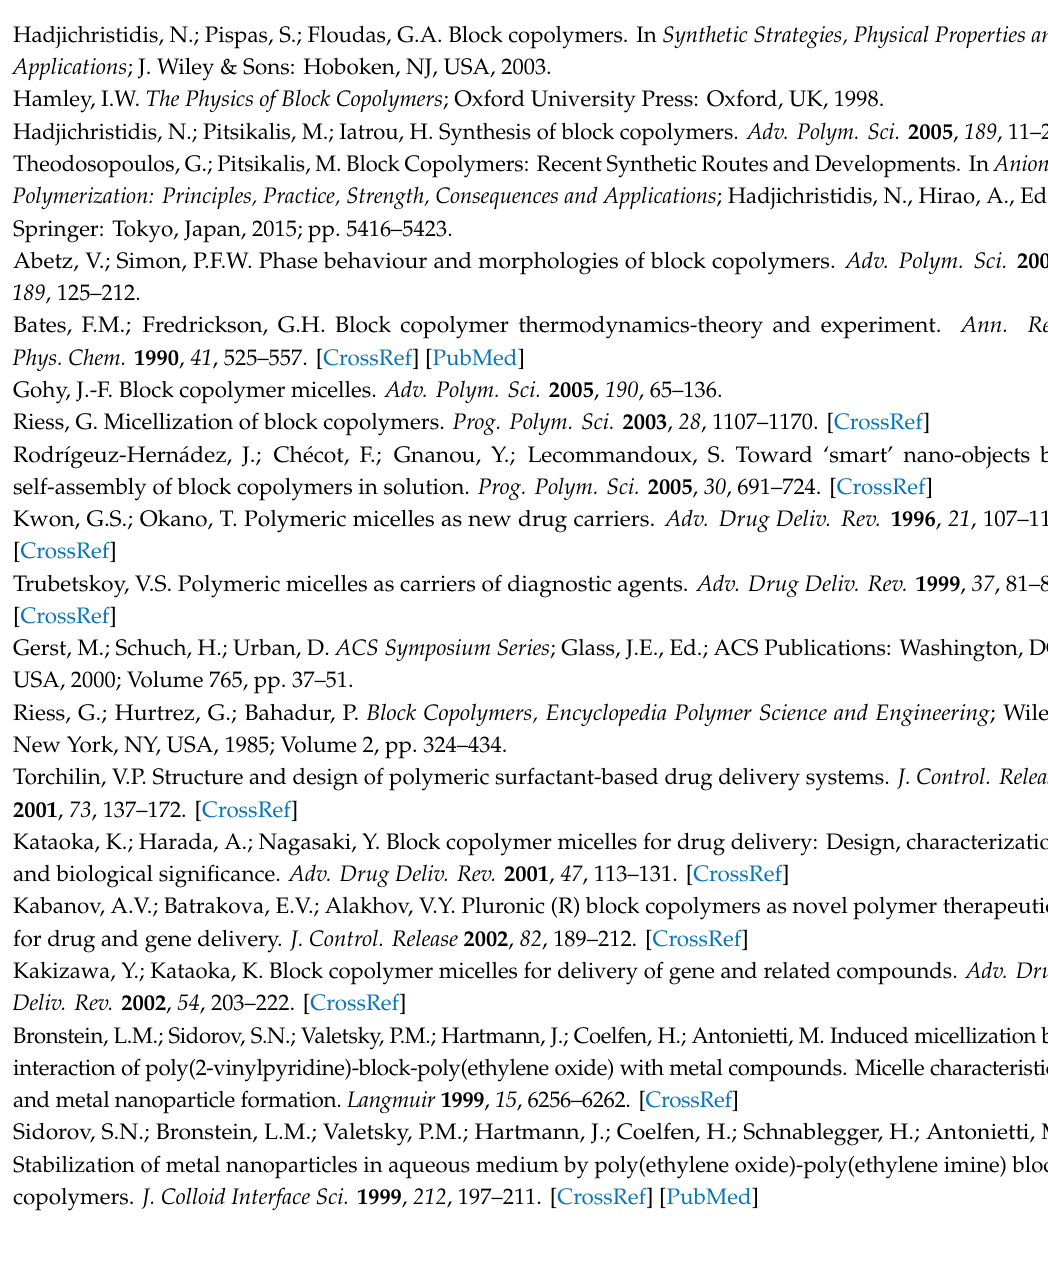
Figure S1: LALLS plot for the sample SH187 / 92 / 8; Figure S2: LALLS plot for the sample SH121 / 90 / 10; Figure S3: DLS plot for sample SH187 / 92 / 8; Figure S4: DLS plot for sample SH14 / 18 / 82; Figure S5: DLS plot for sample HIH; Figure S6: Huggins ( · ) and Kraemer ( • ) plots for sample SHS102 / 46 / 54; Figure S7: Huggins ( · ) and Kraemer ( • ) plots for sample SHS187 / 41 / 59; Figure S8: AFM height image for sample PS(PHIC) 2 36 / 20 /